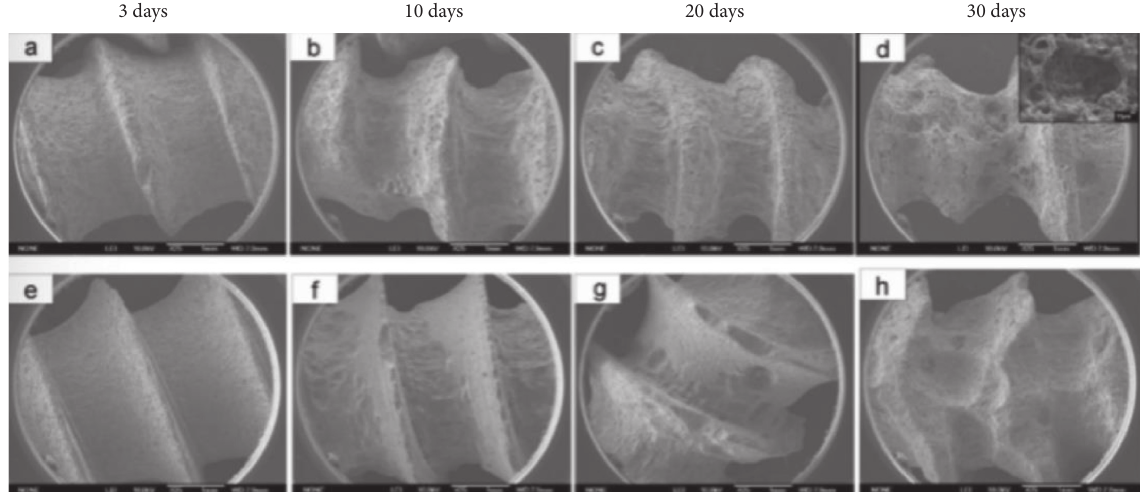
Figure 3: Scanning electron micrographs of the surface morphologies of uncoated MZZ screws (a–d) and MgF after immersion in SBF for different durations